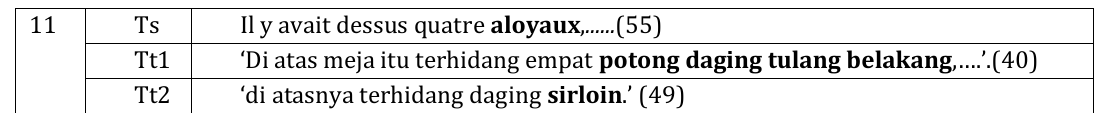
Tableu 11 L’ emprunt anglais 2